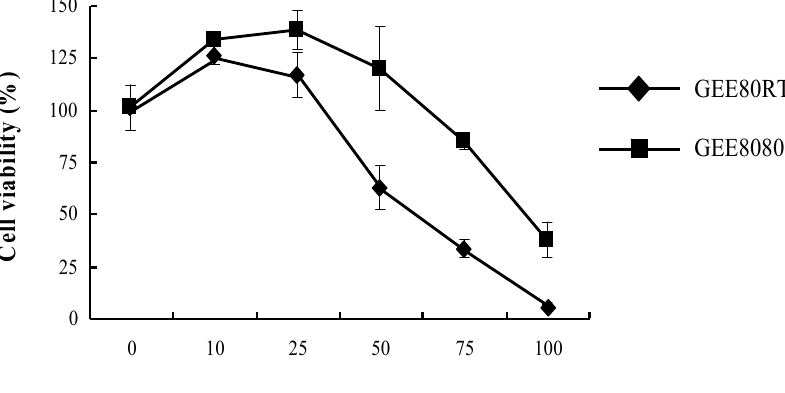
Figure 2. Effects of ginger extracts on cell viability of HepG2 cells. HepG2 cells were maintained in 24-well plates at a density of 10 5 cells/well. Cells were treated with different doses for 24 h. The percentage of viable cells was calculated as a ratio of 570 nm of treated cells versus control cells (treated with 0.1% DMSO vehicle).